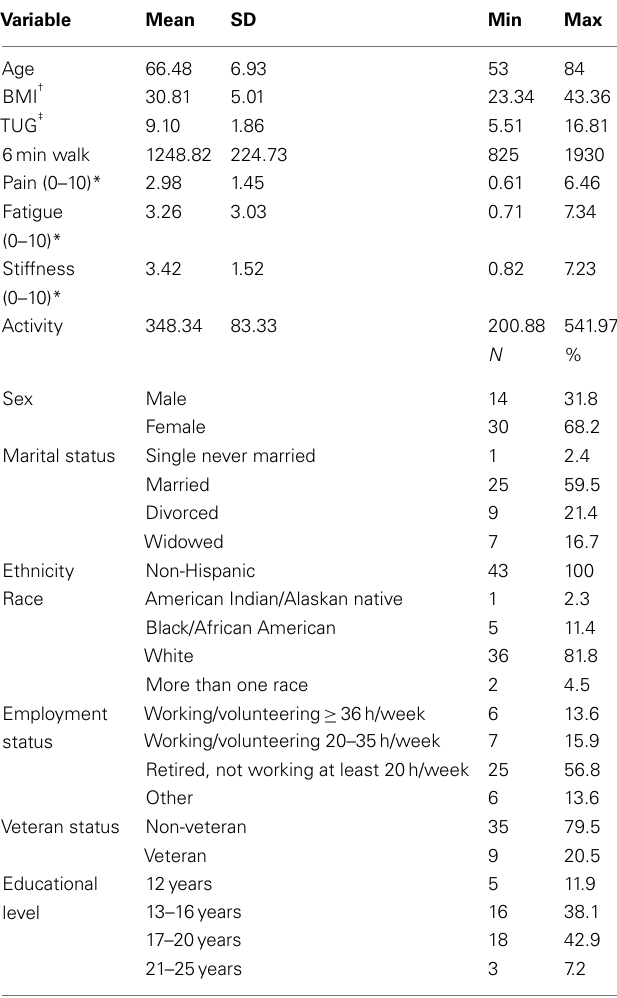
Table 1 | Sample demographics ( N =